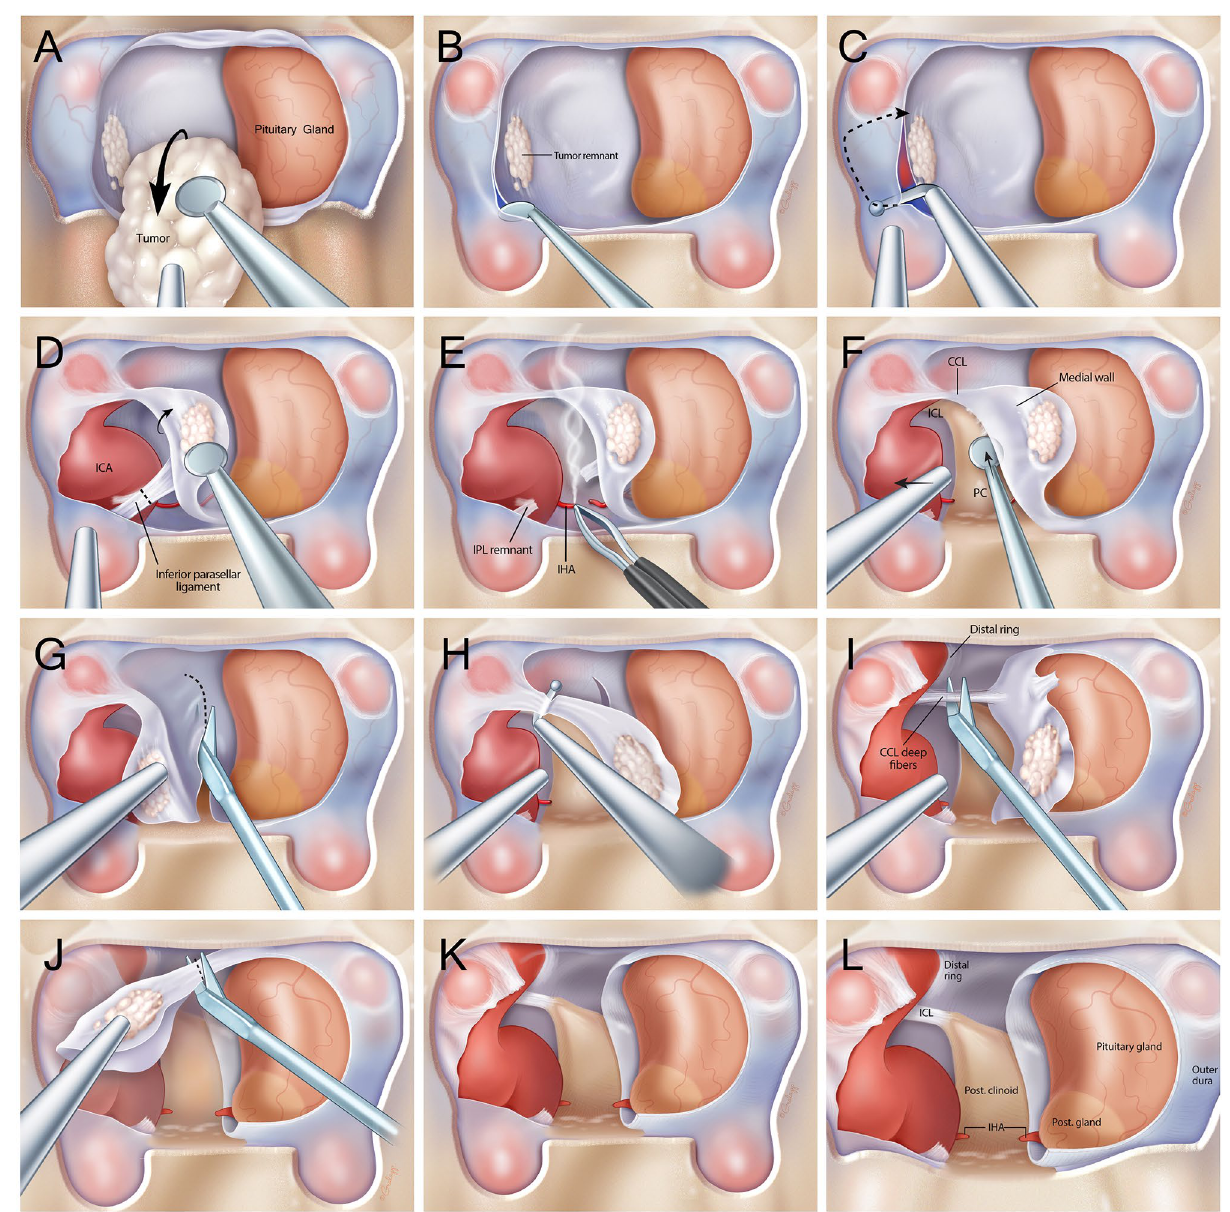
Figure 1. Medical illustrations demonstrating the sequential steps of resecting the medial wall of the cavernous sinus. Wide exposures of the anterior cavernous sinus and paraclinoid carotid artery allow for adequate visualization and safe removal of the medial wall. ( A ) Pituitary adenoma is resected under high resolution endoscopy with bimanual technique preserving the normal pituitary gland ( B ) The medial wall is adequately visualized with high resolution angled endoscopes once the bulk of the adenoma has been removed, tumor remnants that are intraoperatively viewed to adhere strongly to the medial wall suggests invasion necessitating resection. The anterior cavernous sinus is entered by developing a plane between the 2 layers of dura of the intercavernous sinus ( C ) Using a right angled blunt tipped feather blade, the anterior cavernous sinus wall is cut and hemostasis is achieved ( D ) The inferior parasellar ligament (IPL) is one of the first ligaments encountered and is cut to allow mobilization of the medial wall away from the carotid artery ( E ) The inferior hypophyseal artery is often encountered next and is coagulated and cut to avoid any evulsions off the carotid artery ( F ) the dura overlying the base of the posterior clinoid forms the posterior wall of the cavernous sinus and is dissected off the clinoid till the surgeon encounters the horizontal fibers of the carticoclinoidal ligament (CCL) ( G ) Microscissors are used to cut the dura covering the dorsum sella to deatch the meial wall from its sellar attachments ( H ) Using the right angled feather blade, the CCL fibers are cut to begin detaching the medial wall from the carotid artery ( I ) There are often deep fibers of the CCL that require further transection to completely untether the medial wall from the carotid artery ( J ) Once all the fibers of the CCL are cut, the medial wall is now completely free from any attachments to the carotid artery and the only remaining cut are dural attachments that make up the proximal dural ring ( K ) The medial wall is now completely free from attachments and often sent en bloc if it is not severely distorted by tumor invasion leaving behind and open cavernous sinus with an exposed carotid artery. ( L ) The remaining view should show the medial surface of the carotid artery in the cavernous sinus with visualization of the superior compartment of the cavernous sinus and the interclinoidal ligament